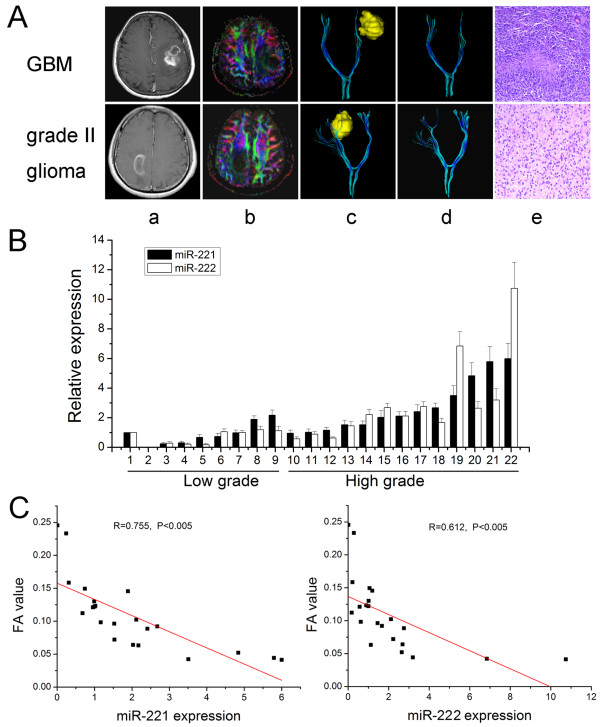
DTI and expression of miR-221 and miR-222 in gliomas. (A) DTI in glioma. a: contrast enhanced T1-weighted MRI; b: FA color map; c and d: three-dimensional reconstruction of the fibers surrounding the glioma (yellow); e: HE stain. (B) MiR-221 and miR-222 expression in 22 glioma tissues assayed by real-time PCR. (C) Correlation between FA values and miR-221 and miR-222 expression in these 22 gliomas by the Pearson correlation analysis.